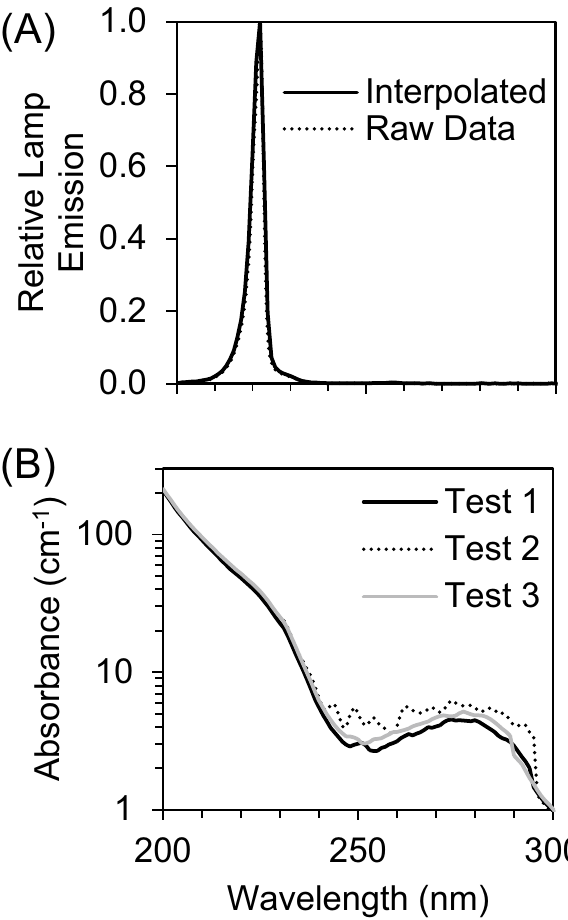
Figure 1. ( A ) The raw spectral emission from 200 to 300 nm of the filtered KrCl excilamp (USHIO Care222 ® ) was interpolated and relativized to the peak emission at 222 nm for use in UV dose calculations. ( B ) The absorbance spectrum from 200 to 300 nm of SARS-CoV-2 at ~ 10 5 PFU/mL in cDMEM was measured for each of three biologically independent Tests for use in UV dose calculations. Expanded emission and absorbance spectra from 200 to 800 nm are shown in Supplementary Fig.